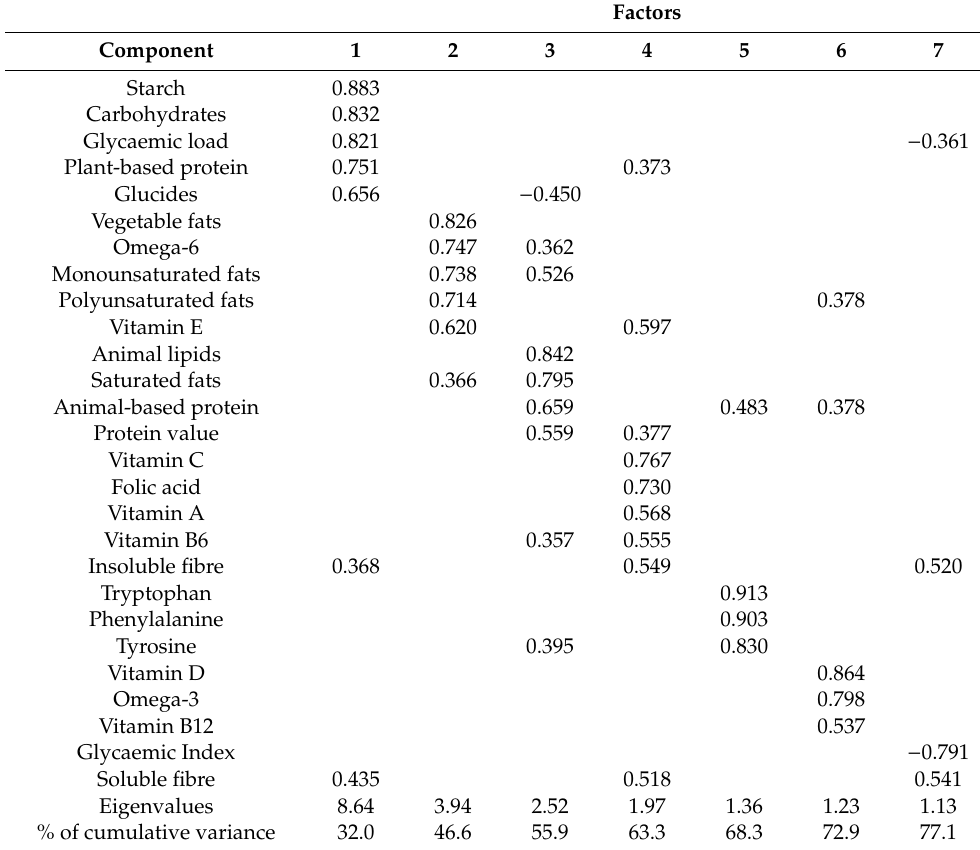
Table 1. Factor analysis results. Only the components’ values significantly related to each factor are